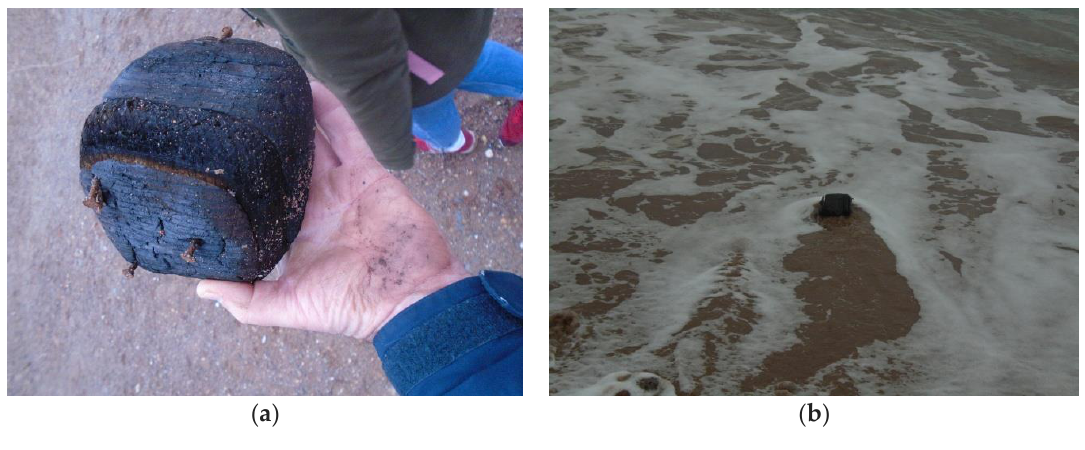
Figure 24. ( a ) Charred wood; ( b ) Charred wood in waves.